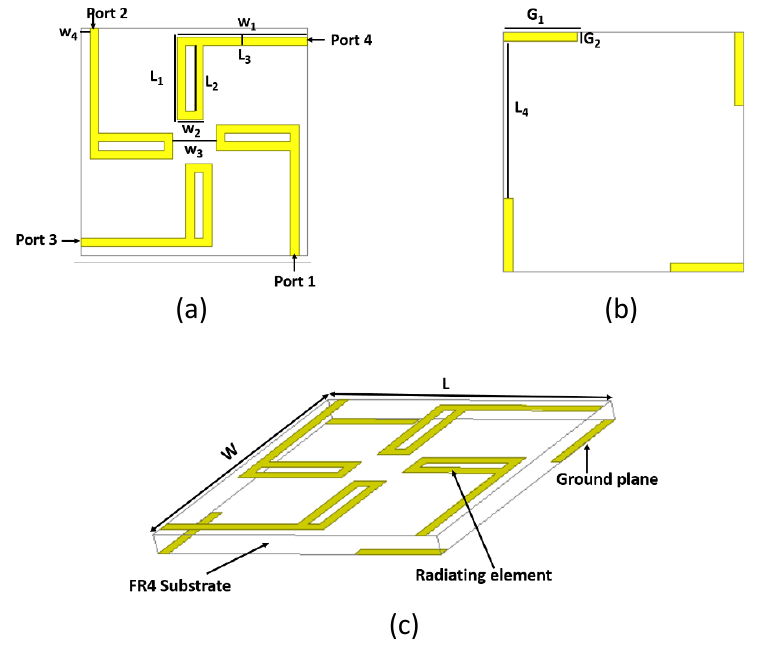
Figure 1. Multiple-input multiple-output (MIMO) antenna structure; ( a ) Top view; ( b ) ground view; ( c ) 3D view.